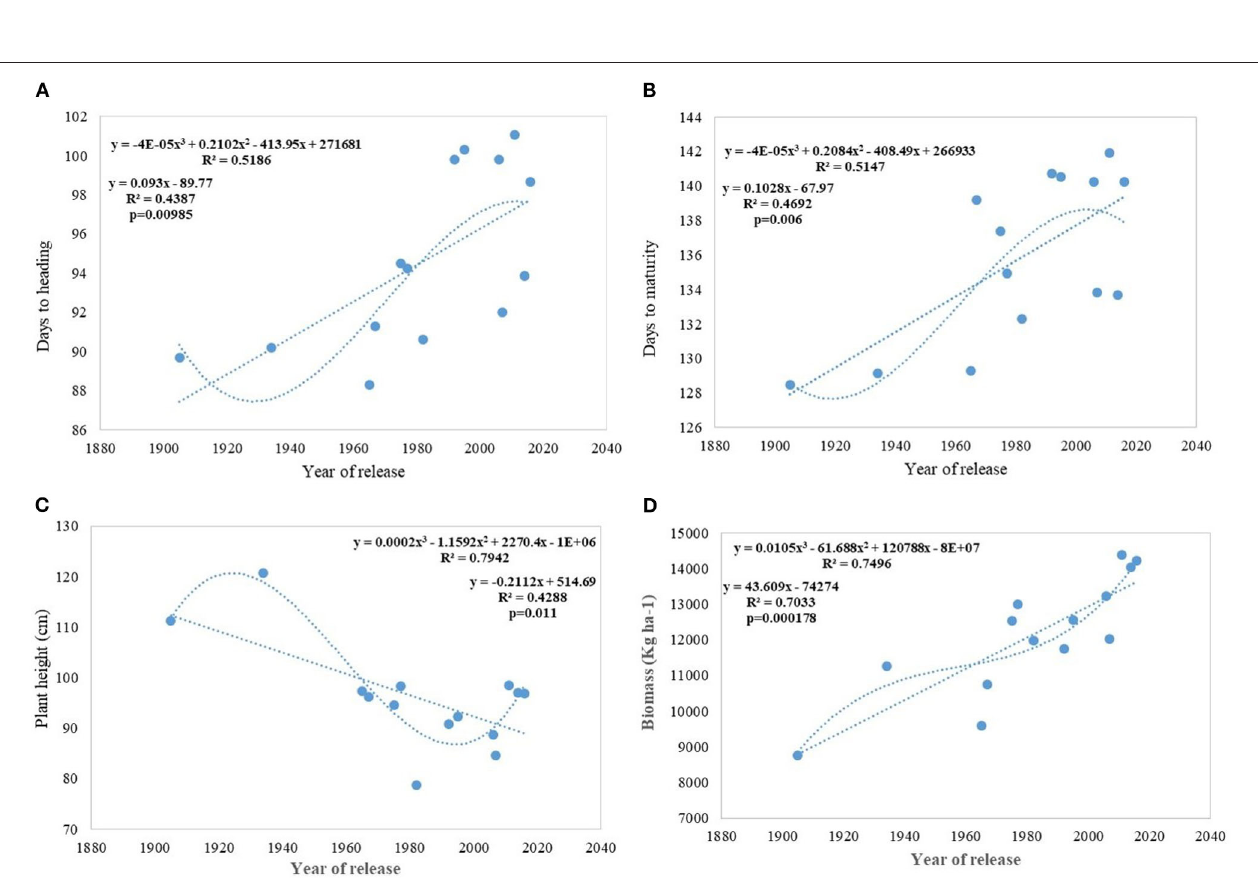
FIGURE 3 | Regression equation between phenological traits and yield component traits against the year of release. (A) Days to heading, (B) Days to maturity, (C) Plant height (cm), (D) Biomass (Kg ha − 1 ).